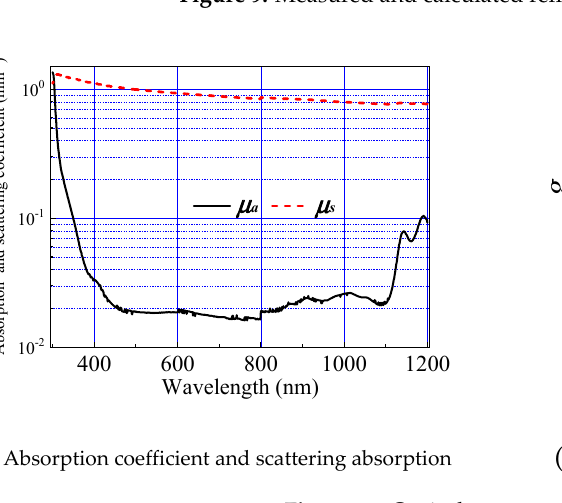
Figure 10. Optical parameters of phantom.